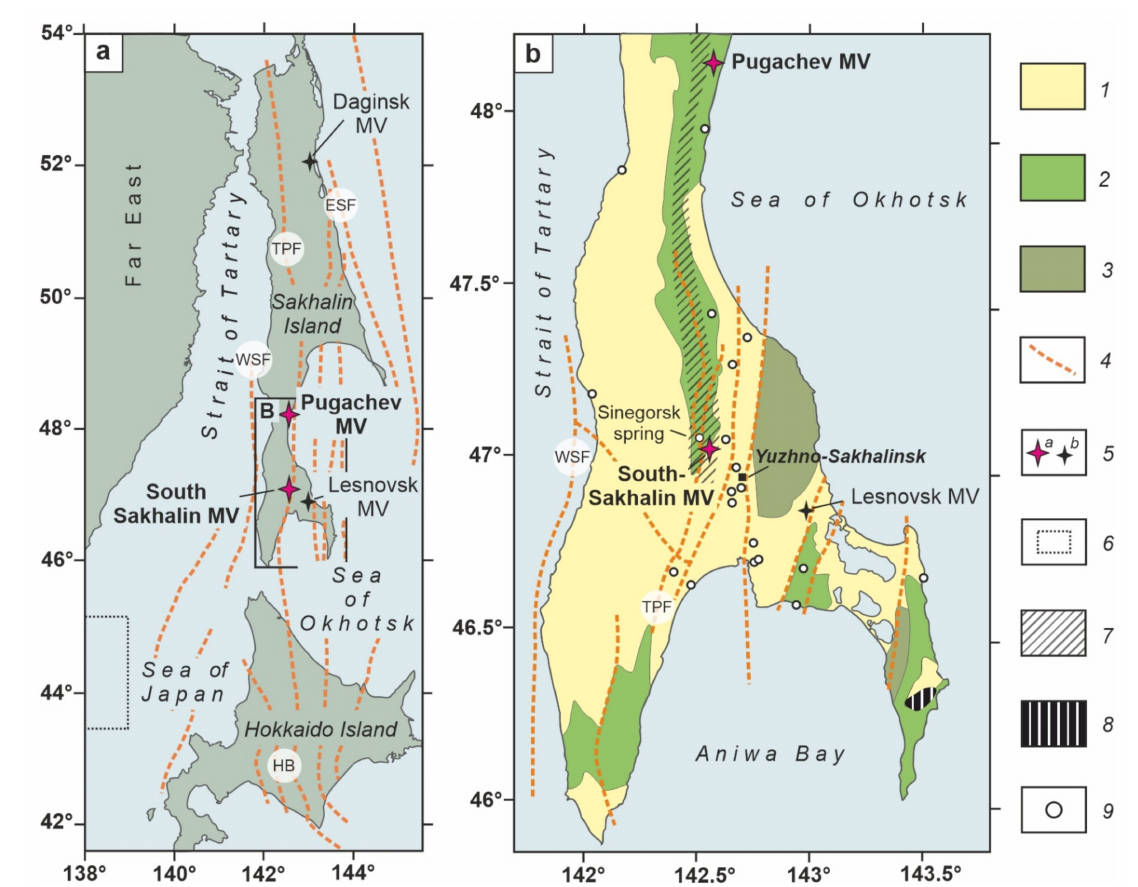
Figure 1. Geological sketch of the Sakhalin mud volcanic province. ( a ) Location map of mud volcanoes in Sakhalin province. ( b ) Enlarged box from panel ( a ): southern Sakhalin Island. Rock formations: 1 = Cenozoic (mostly Paleogene-Neogene) sediments; 2 = Mesozoic (K) rocks; 3 = Paleozoic rocks, after [26]; 4 = faults, after [20], abbreviated as: ESF = East Sakhalin Fault, HB = Hidaku Belt, TPF = Tym-Poronay Fault, WSF = West Sakhalin Fault. 5 = sampled ( a ) and unsampled ( b ) mud volcanoes; 6 = aureoles of atmochemical mercury dispersion, after [27]. Mineragenic zone after [28]: 7 = the belt of Sb-Hg mineralization; 8 = Neogenic Ge-rich coal. 9 = hot springs and boreholes, after